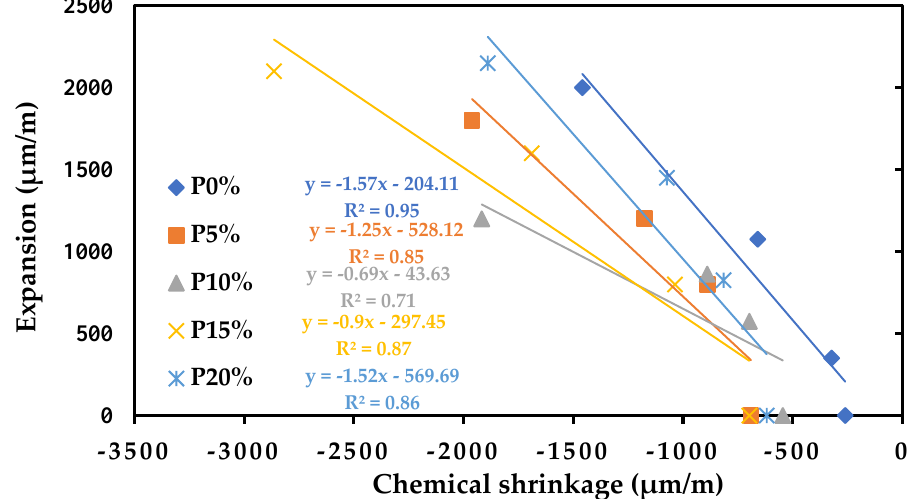
Figure 16. Correlation between chemical shrinkage and drying shrinkage for pastes.